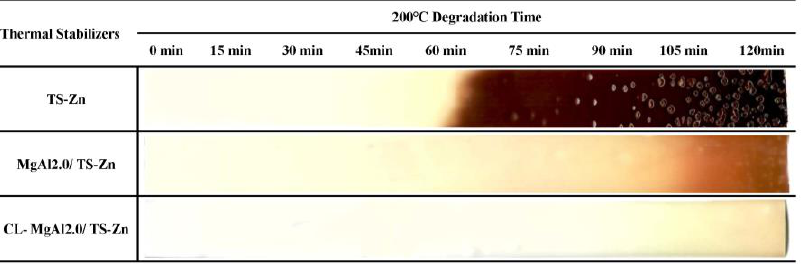
Figure 12. Comparison of the thermal stability of PVC reinforced with MgAl2.0 and its crosslinked counterpart